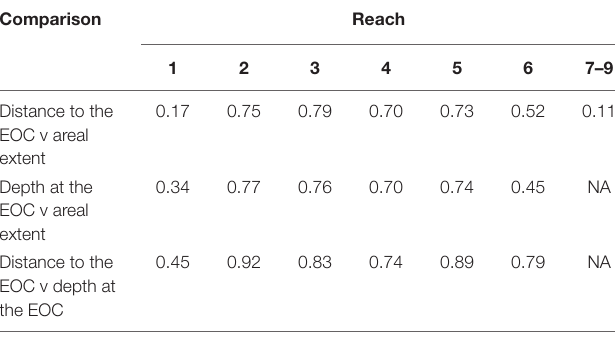
TABLE 2 | Pearson correlation coefficients based on range standardized